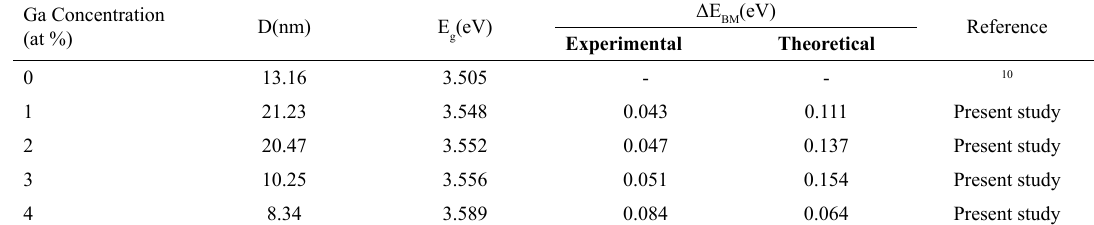
Table 1. Average crystallite size (D), energy gap (Eg) and experimental and theoretical values of Burstein-Moss shift (ΔE and Ga doped Zn